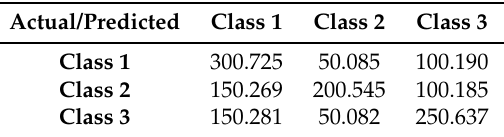
Figure 23. Classification map of vertical profile classes. Top left : ground truth; Top right : Prediction; Bottom : legend with examples of profiles corresponding to each class. Table 5. Confusion matrix of vertical profiles classes.